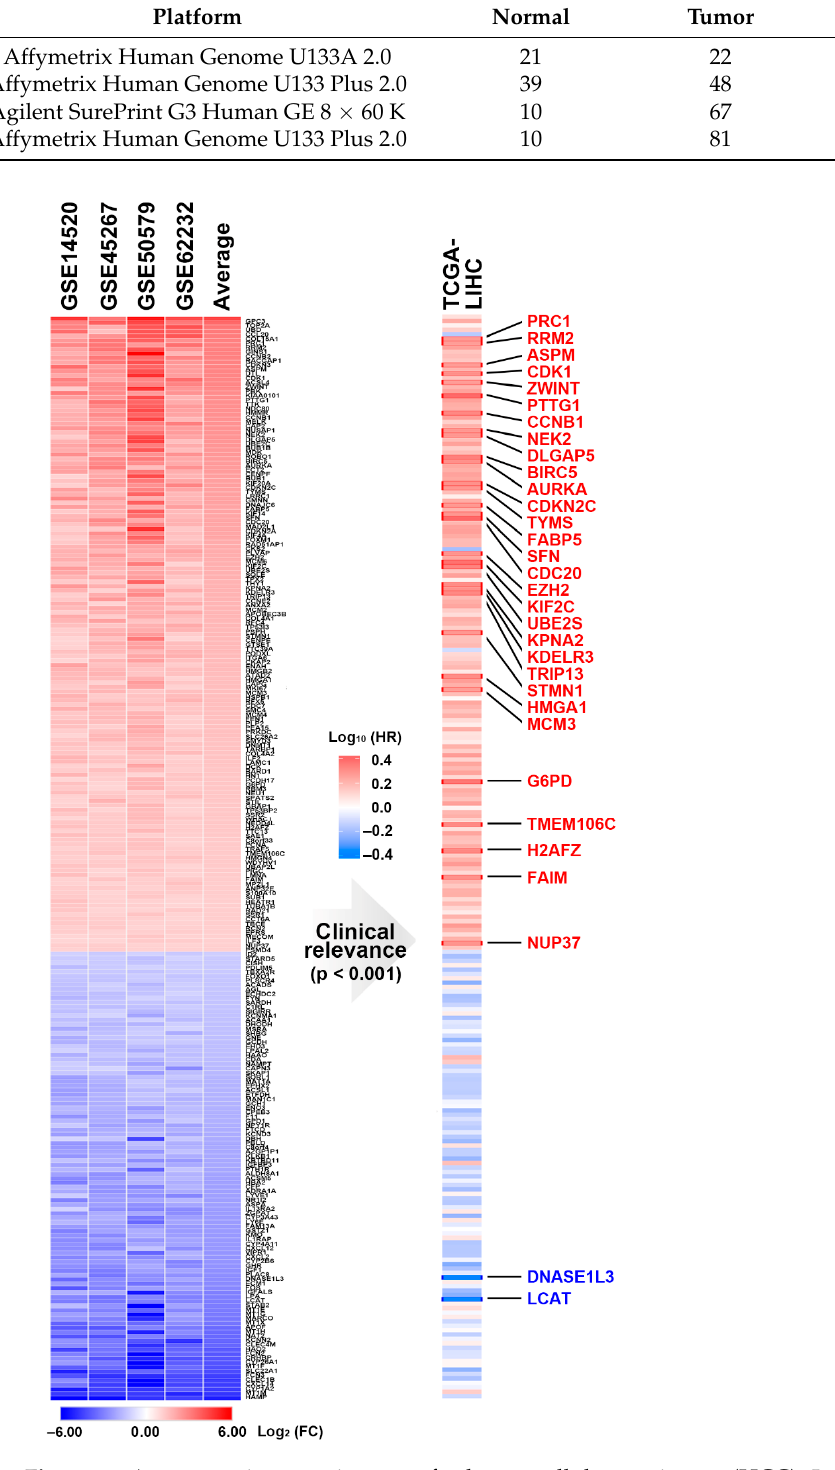
Figure 1. A prognostic gene signature for hepatocellular carcinoma (HCC). Left : The common gene signature in HCC was obtained from four data sets and ranked according to the average gene expression levels. Right : The prognostic impact of each gene in HCC was analyzed using the TCGA- LIHC data set. The genes highlighted in red or blue indicate these genes predicted better or poorer overall survival of HCC patients, respectively.